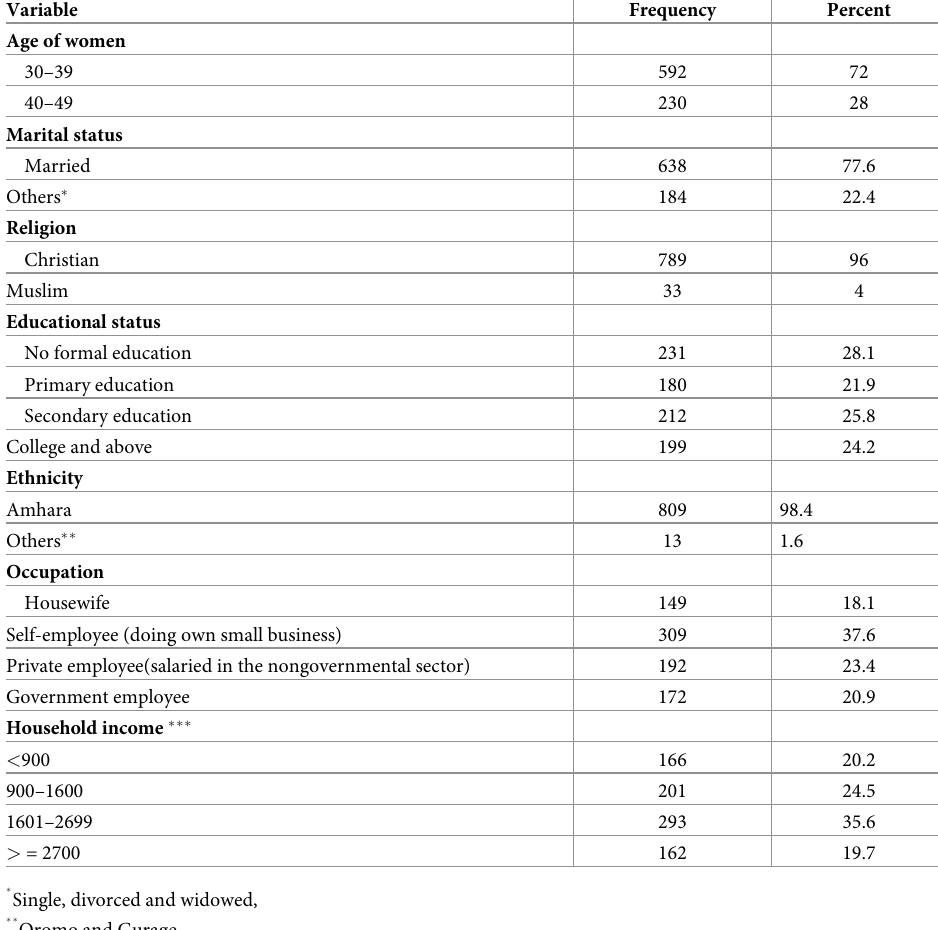
Table 1. Sociodemographic characteristics of women (n = 822) age 30–49 in Debremarkos town, Northwest Ethio- pia, 2018.